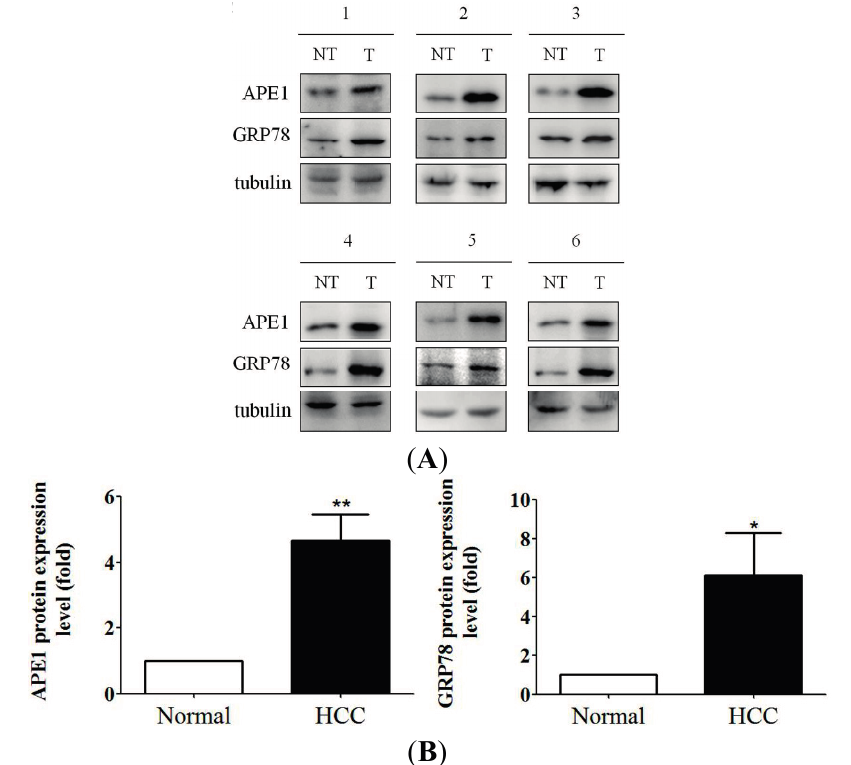
Figure 6. Highly APE1 expression was observed in ER stress-correlated human liver tumor tissue. ( A ) Increased APE1 is associated with high GRP78 expression in human liver tumor tissues in vivo . The expression of APE1 and GRP78 in control liver tissue and tumor tissue were determined by Western blotting for six individual samples; ( B ) The expression levels of APE1 and GRP78 were quantified by using ImageJ software. The data represent the mean of APE1 protein expression level from three independent experiments. Columns, mean; bars, SD ( n = 3). Significant differences ( * , p < 0.05 and ** , p < 0.01) between the control and experimental group are marked with an